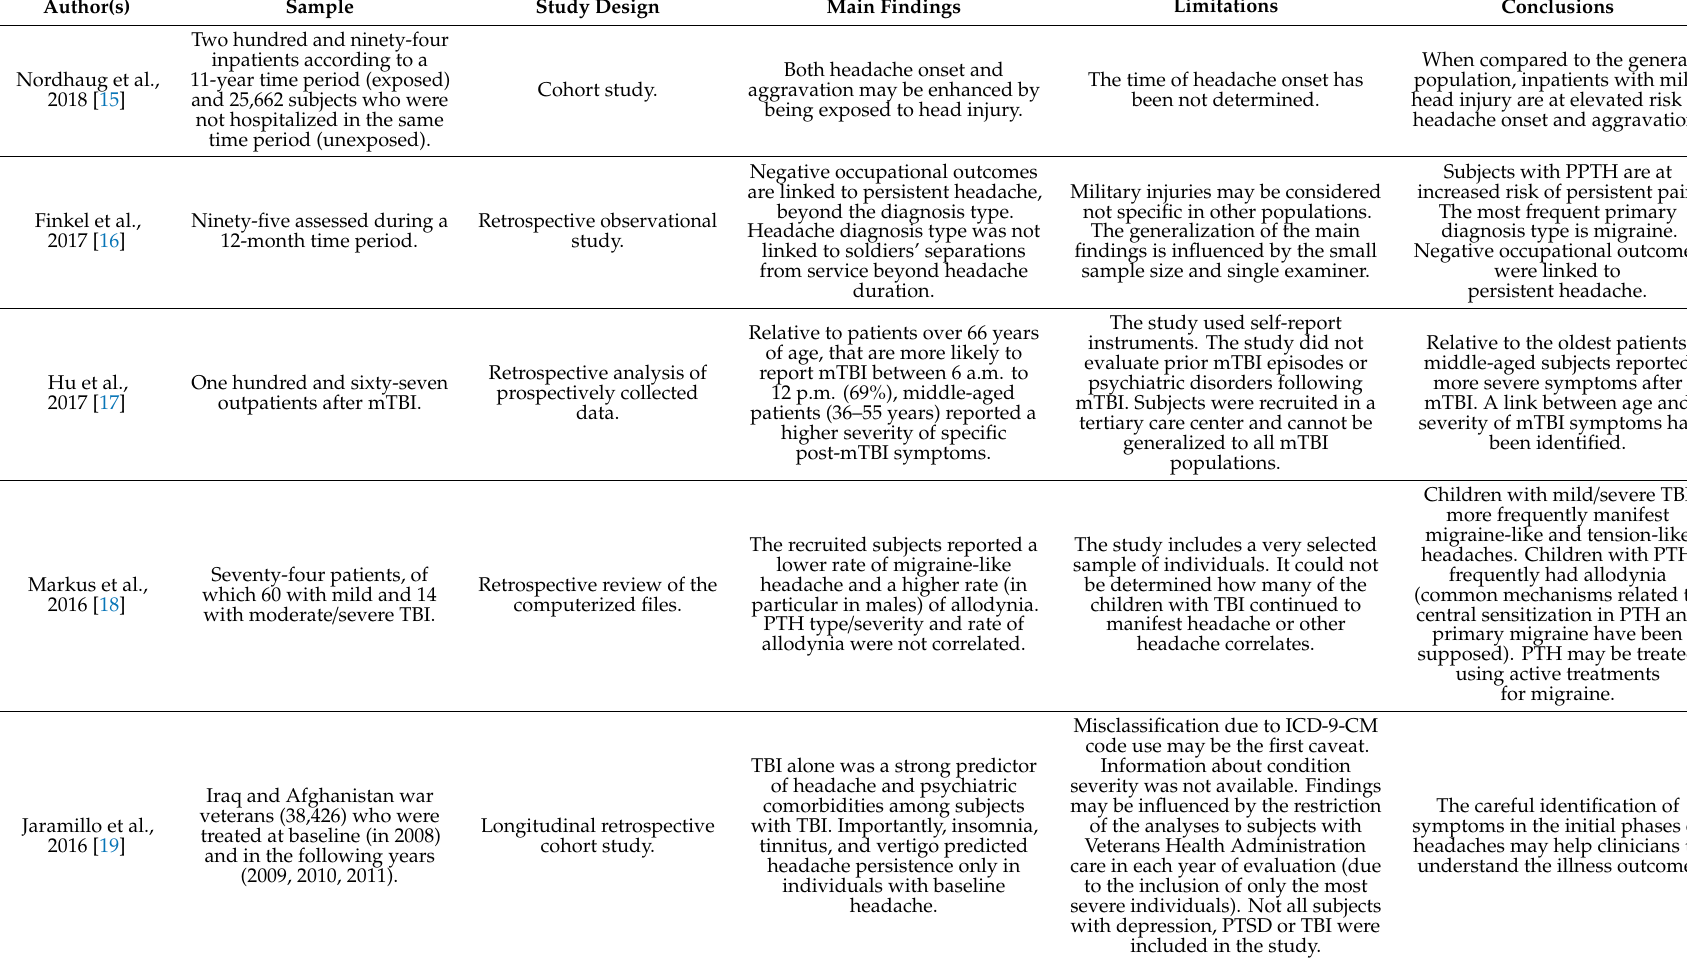
Table 1. Most relevant clinical studies about persistent post-traumatic headache